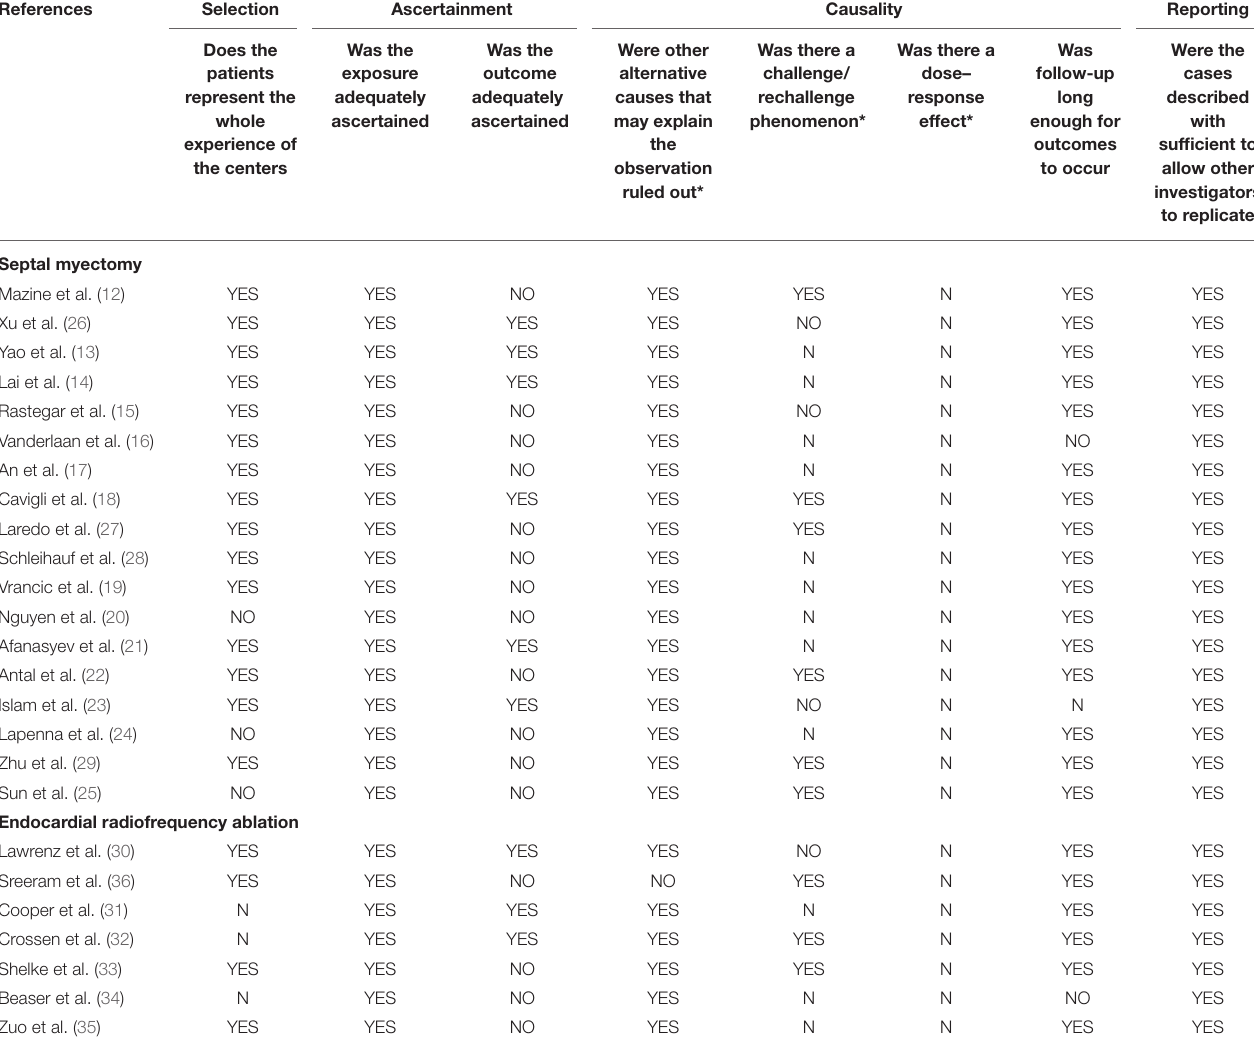
TABLE 2 | Quality assessment of the included